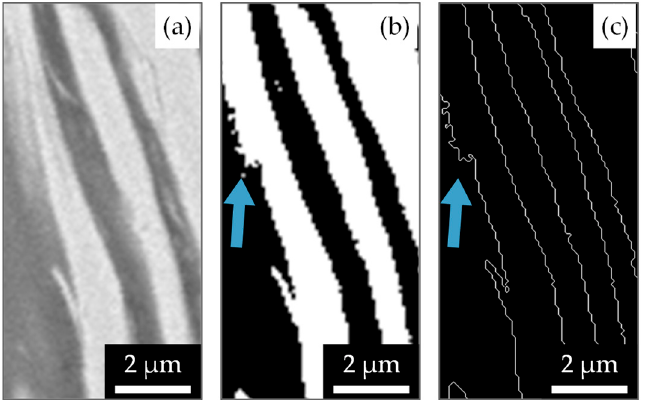
Figure 3. Generation of the boundary lines based on the initial greyscale SEM image: ( a ) section of the original SEM image; ( b ) generation of a binary image (step 1); ( c ) deletion of pixels, enlargement of the image, and application of the edge filter (steps 2–4).